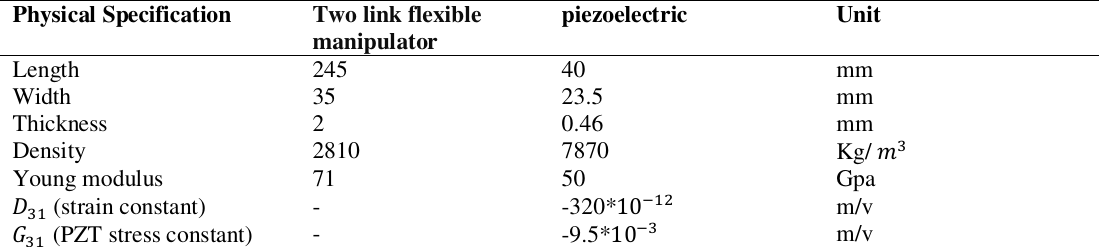
Table 2, The flexible manipulator physical and geometrical characteristics, as well as the piezoelectric . Physical